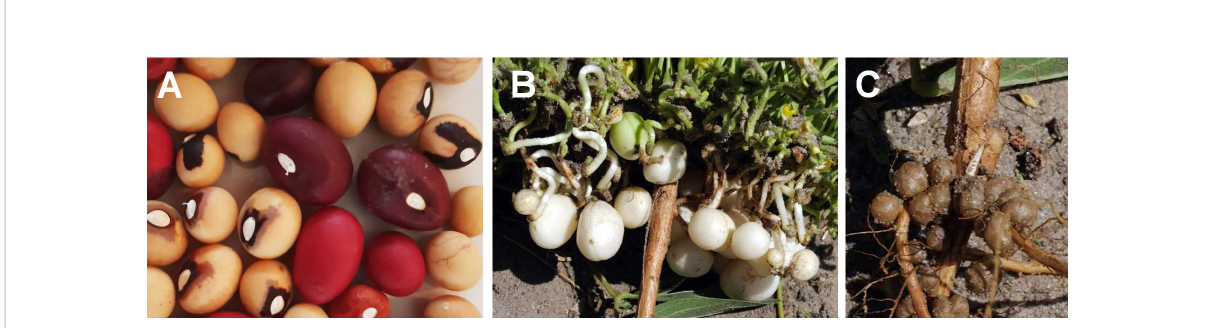
FIGURE 1 Examples of Bambara grounduts. (A) Dehulled grains in various colours, here from cream to dark brown. (B) Freshly harvested Bambara groundnuts. (C) Symbiotic root nodules of fi eld-grown Bambara